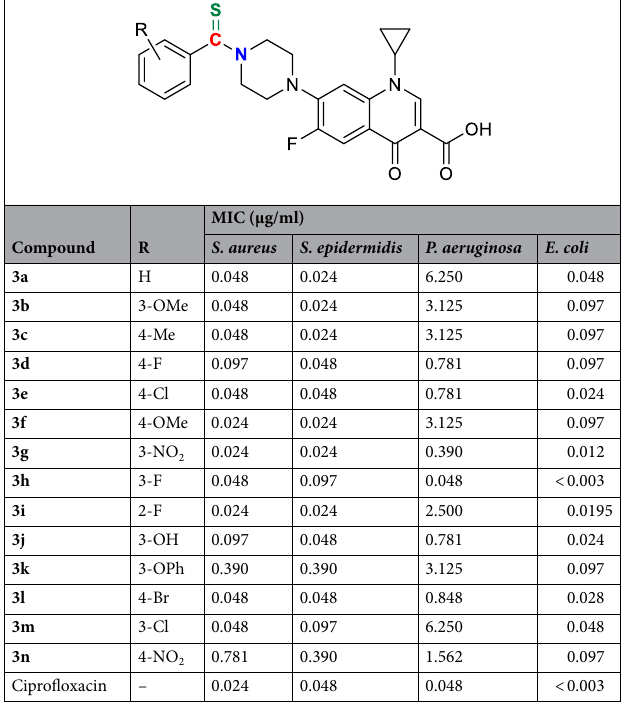
Table 2. Structure and antibacterial activity of compounds 3a–n